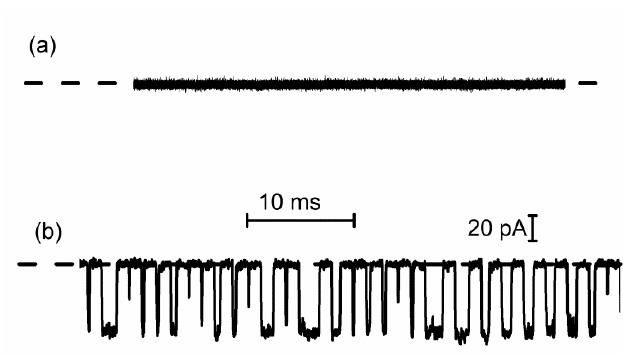
Figure 16. DNA translocation through single lysenin channels. ( a ) ssDNA addition to the headstage wired reservoir biased by a negative potential does not elicit transient changes in the open current through a single lysenin channel, indicative of absence of translocation; ( b ) ssDNA addition to the opposite side (grounded reservoir) and application of a positive voltage to the headstage-wired reservoir leads to events resembling translocation.